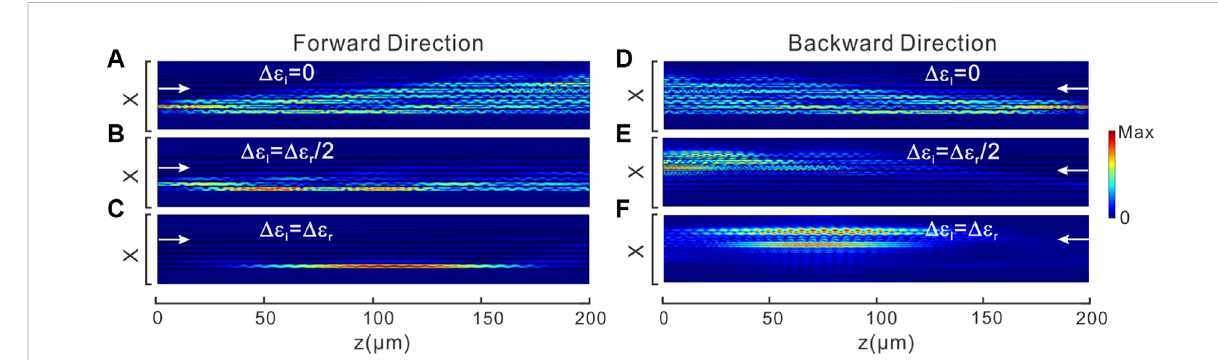
FIGURE 4 Wavedynamicsfordirection-dependentNHSE. (A – C) Arethedistributionsofelectric fi elds(| E |)forforwarddirectionwith Δ ε i =0, Δ ε r /2,and Δ ε r , respectively. (D – F) Are the fi eld distributions for backward propagation. The arrow in the insert denotes the propagation